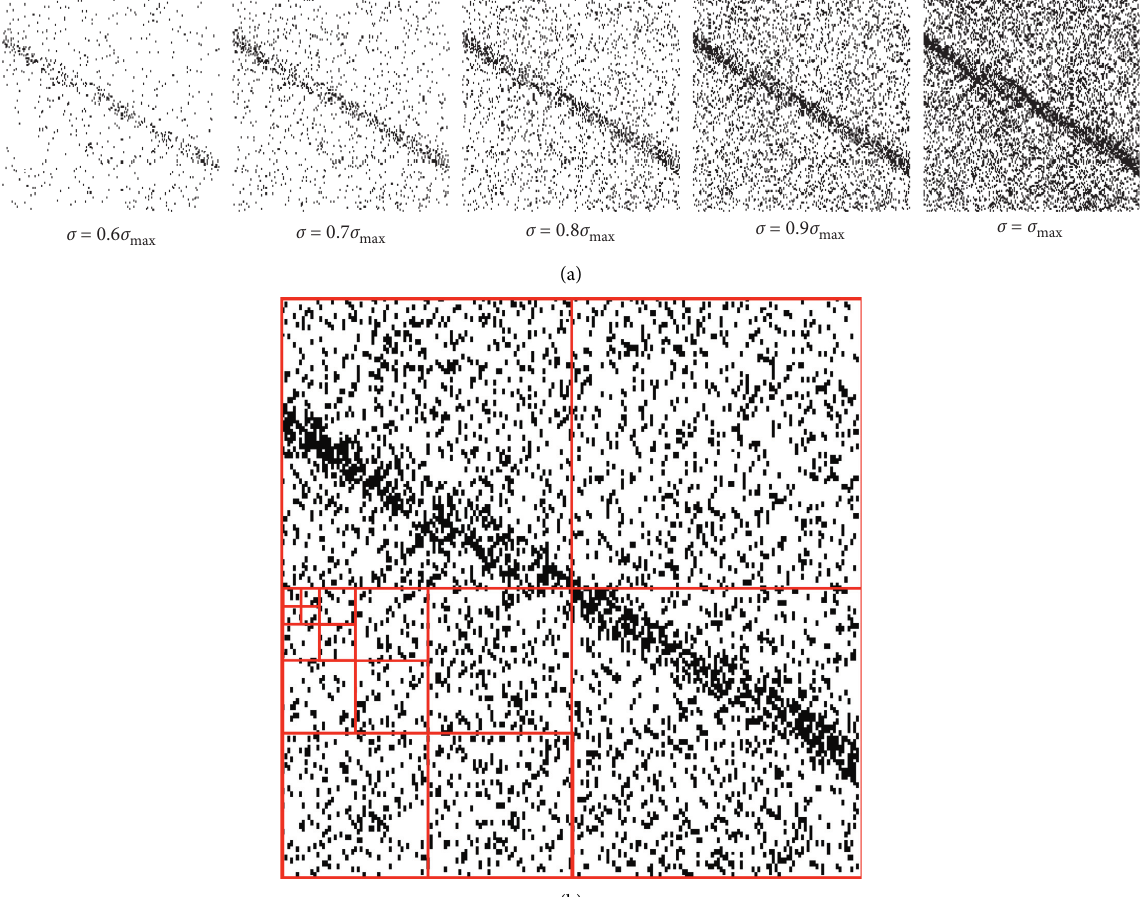
Figure 12: Schematic diagram of box dimension calculation for damage zone of sandstone mesoelement. (a) Binary image of damage evolution at different stress levels ( α � 30 ° ). (b) Sketch for box dimension during rock failure